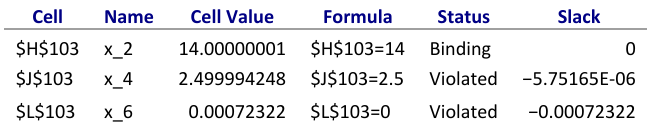
Figure 19. Feasibility Report generated by Excel’s Solver for optimal control problem (17)–(29).